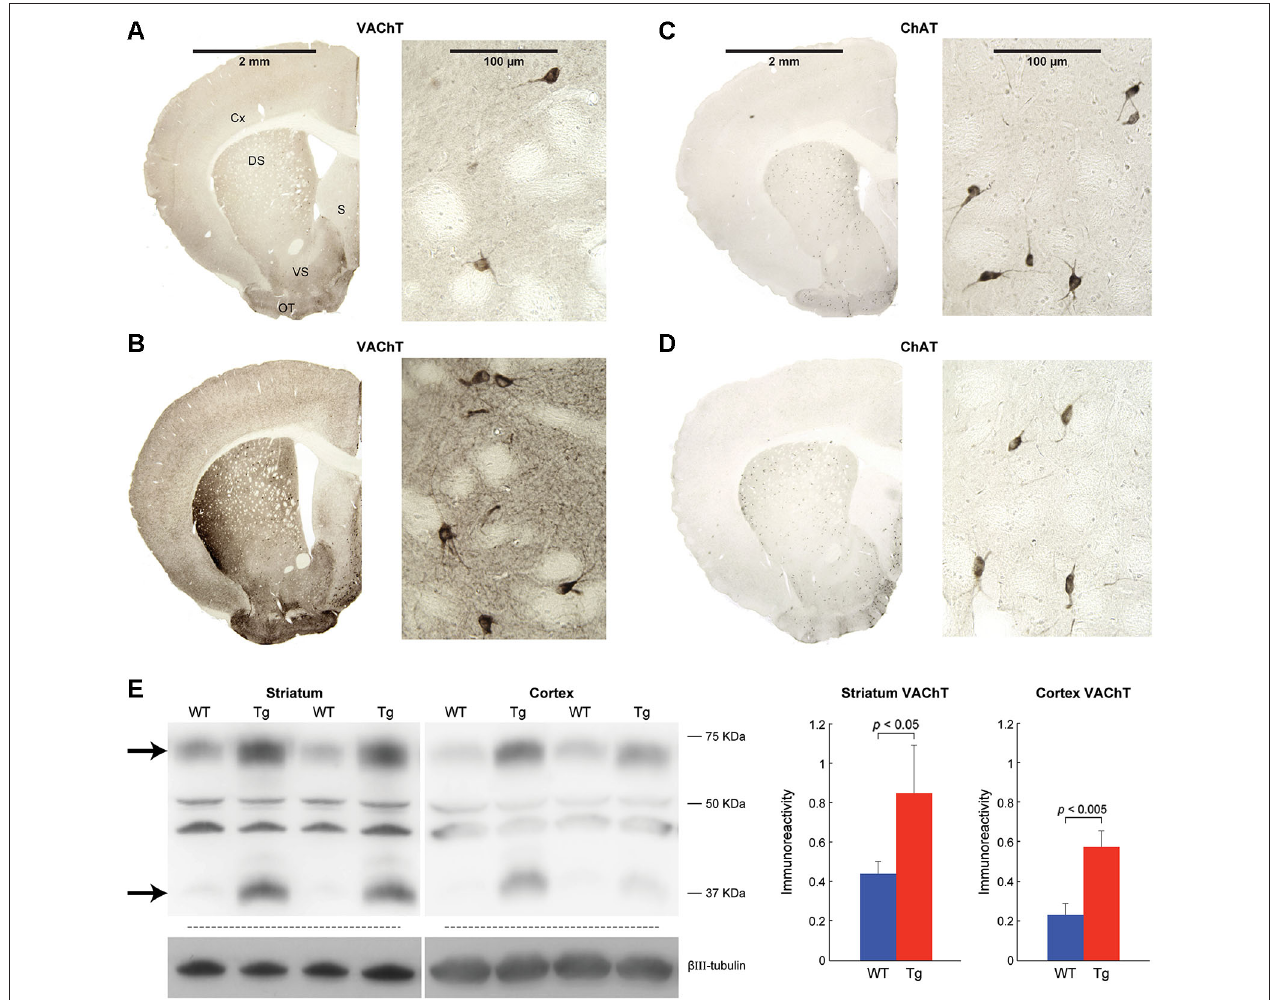
septum, OT: olfactory tubercle. (E) Immunoblots and corresponding graphs for VAChT expression in wildtype mice (WT) and sibling ChAT-ChR2-EYFP BAC mice (Tg). Arrows point to VAchT-specific bands. Bar graphs represent immunoreactivity based on densitometry of the upper VAChT-specific band, relative to neuron-specific β III-tubulin in wildtype (blue, n = 3) and ChAT-ChR2-EYFP BAC (red, n = 3) mice. Values shown are mean +